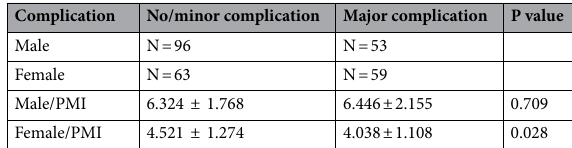
Table 2. The correlation between postoperative major complications and sarcopenia. PMI, Psoas muscle index